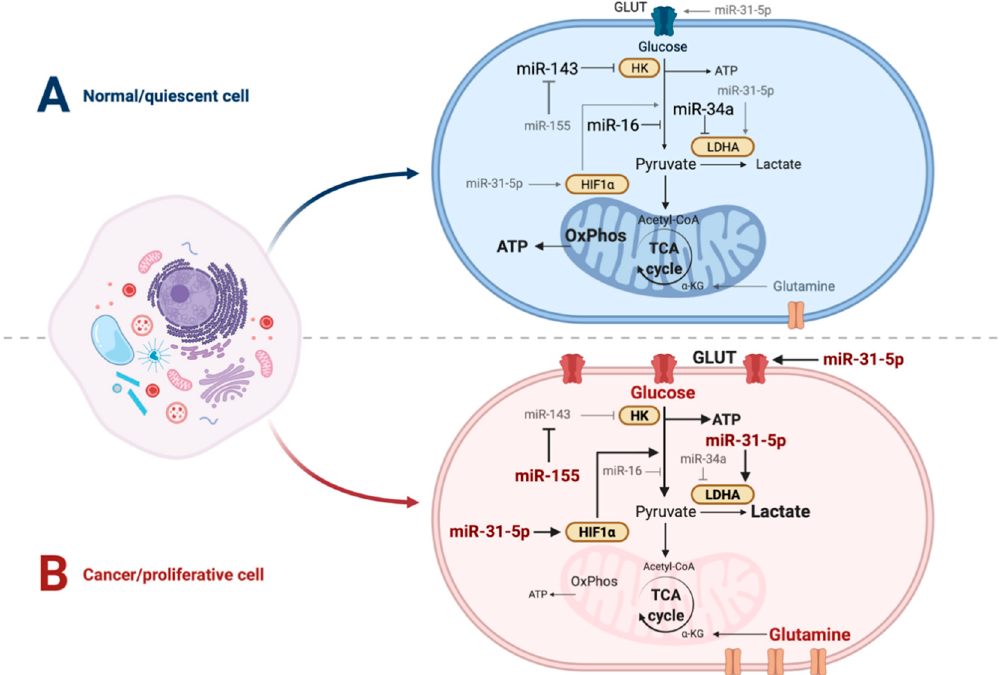
Figure 1. Regulation of glucose metabolism by miRNAs in quiescent versus proliferative cells. The figure depicts the main alternative energy metabolism pathways in human cells, with their relative usage in normal quiescent cells ( A ) and cancer and highly proliferative cells ( B ) represented by different levels of transparency. Known regulatory miRNAs, their direct mRNA targets (HK, LDHA and HIF1 α ), and certain indirect miRNA regulatory interactions with other miRNAs or pathway reactions are represented, with letter size distinguishing their abundance. Pointing arrowheads represent stimulatory interactions, while blocking arrows represent inhibitory interactions. Pathway and metabolite labels highlighted in bold and thickened lines denote their predominance in each setting.